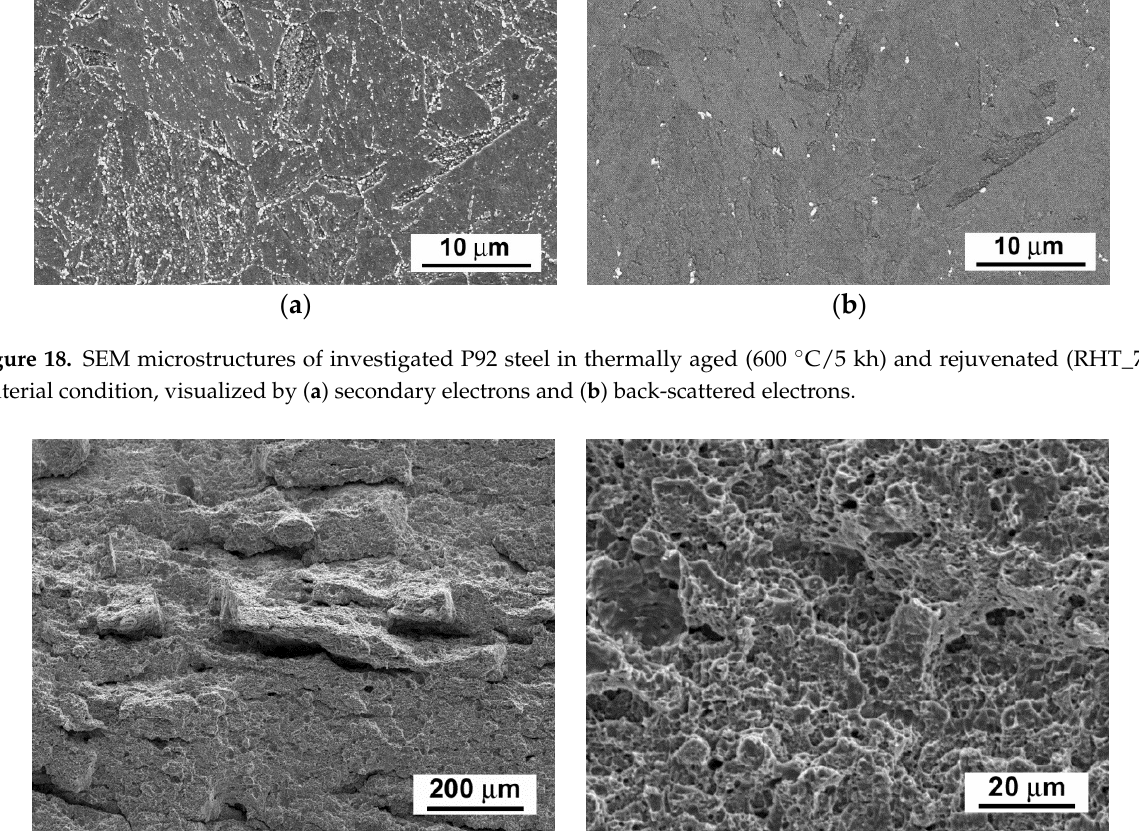
Figure 19. SEM fractographs of fractured impact toughness test specimen of P92 steel material after the Charpy impact bending test: ( a ) overall view on fracture surface and ( b ) detailed view on ductile dimple fracture micro-mechanism.